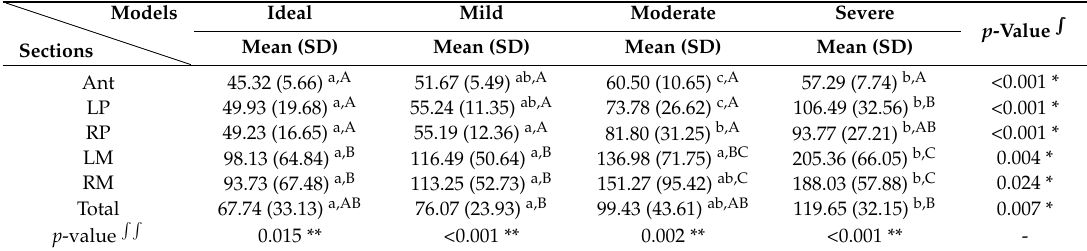
Table 1. Comparison of deviations in the scanned images of the four models using iTero ® (unit: μ m).